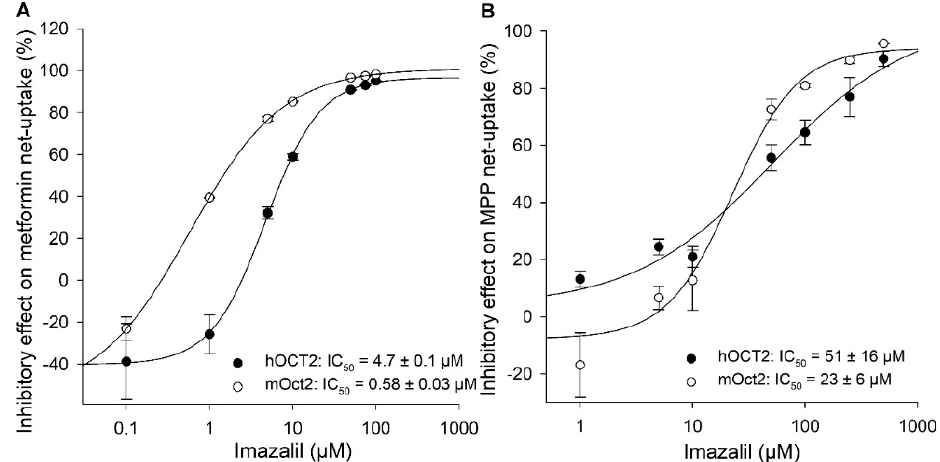
Figure 6. Concentration-dependent inhibitory effects of imazalil on hOCT2- and mOct2-mediated metformin ( A ) and MPP ( B ) and transport in transfected HEK293 cells. Each data point represents the mean inhibitory effect (%) calculated from net-uptake of two independent experiments carried out in triplicate ± average deviation (AD). IC50 values were calculated by sigmoidal 4Hill equation using Sigma Plot version 13.0 software.